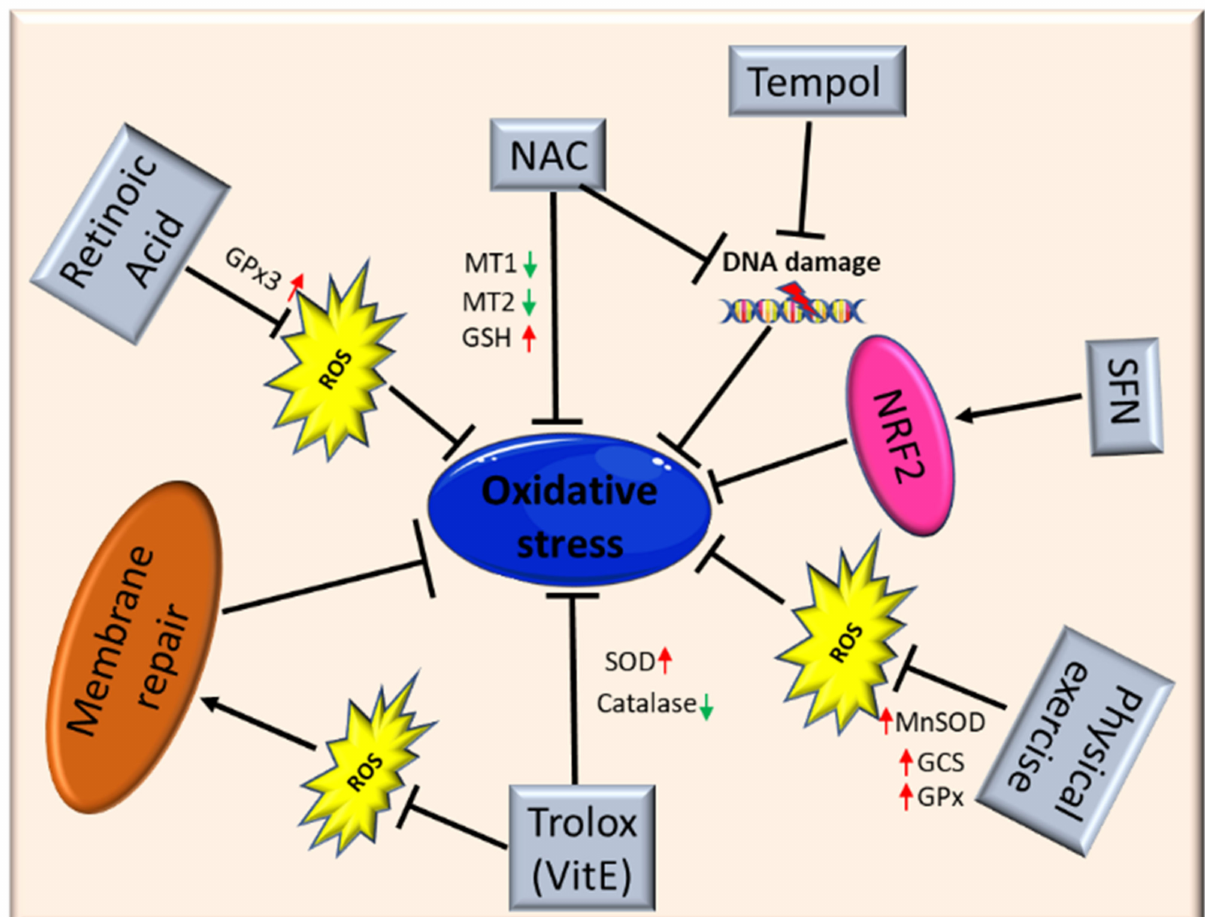
Figure 3. Schematic illustration of antioxidant therapy targets in muscular dystrophies. Abbreviations: ROS: reactive oxygen species; NAC: N -acetylcysteine; MT1: metallothionein 1; MT2: metallothionein 2; GSH: glutathione; SFN: isothio- cyanate sulforaphane; Nrf2: nuclear factor erythroid 2-related factor 2; MnSOD: manganese superoxide dismutase; GCS: γ -glutamylcysteine synthetase; GPx: glutathione peroxidase; SOD: superoxide